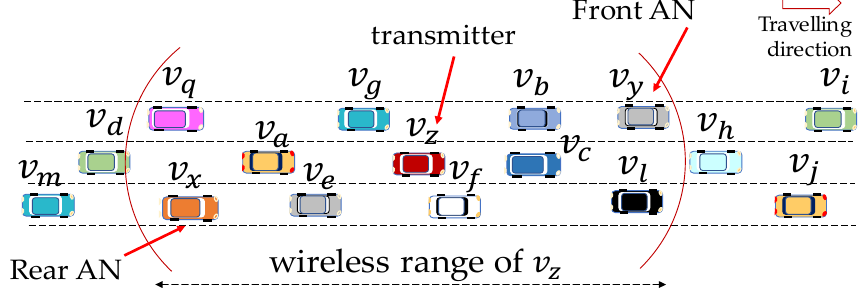
Figure 4. A selection of associative front and rear neighbors.